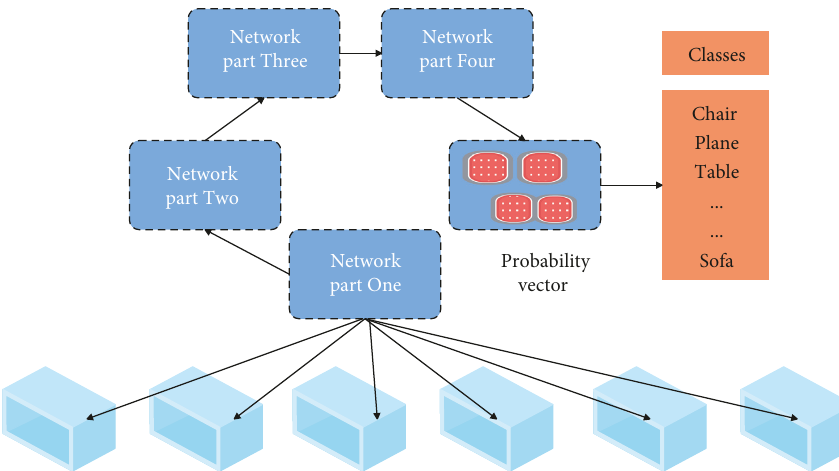
Figure 13: 3D CAD classification model based on knowledge recognition algorithm of convolutional neural